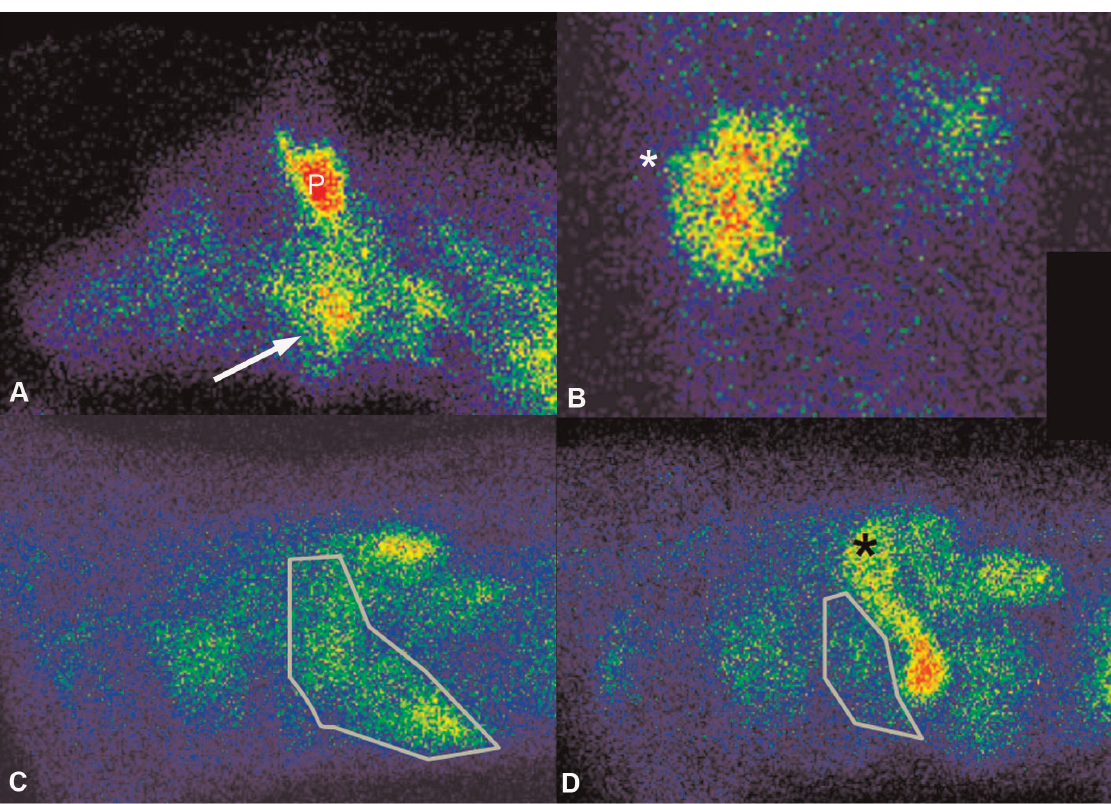
Figure 6. Imaging of dogs with lymphoma using 99m Tc-LLP2A-HYNIC-PEG and 99m Tc-LLP2A-HYNIC. A. Lateral image of the head at 4 h. Mandibular lymph node activity (arrow) in a dog with lymphoma imaged with 99m Tc-LLP2A-HYNIC-PEG. The parotid salivary gland (P) has normal uptake. B. Ventrodorsal projection of the mid-abdomen with head at top of image at 4 h. Renal uptake (white *) in a kidney affected with lymphoma using 99m Tc-LLP2A-HYNIC. C. Lateral pre-chemotherapy of the liver (outlined) of the same dog as in A, with head to the left. D. Post chemotherapy, the liver is smaller and has less activity. There is activity visible in the stomach (black *). Table S3 Organ ratios and percent injected dose in study animals at 2, 4 and 6 hours. Table S4 Specific activity, injected activity, and injected mass of injected compound of normal dogs N1-N3, and NHL dogs L1-L5.